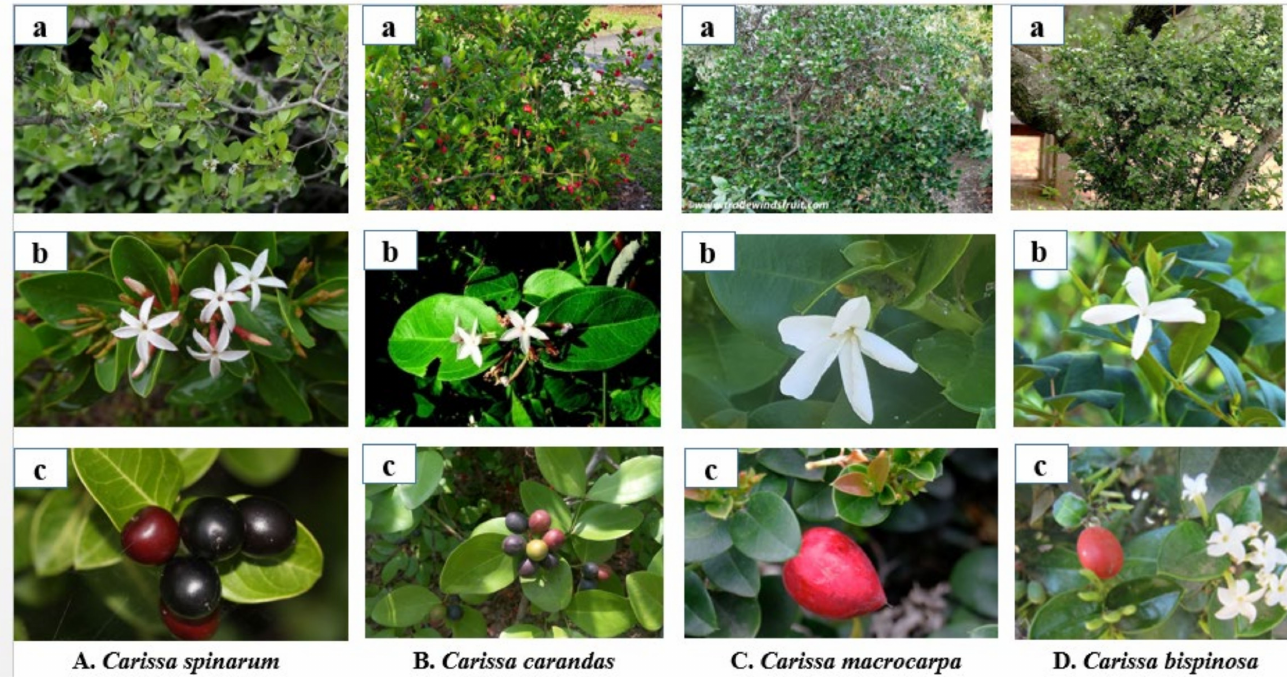
Figure 2. Representative pictures showing morphology of Carissa spinarum ( A ), C. carandas ( B ), C. macrocarpa ( C ), and C. bispinosa ( D ): a—whole plant; b—flower; c—fruit. Sources: C. spinarum